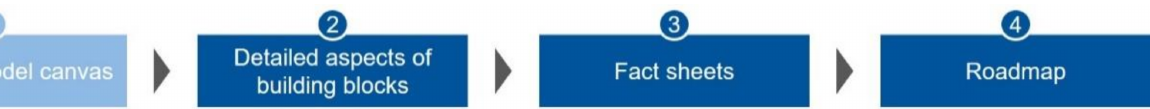
Figure 6. From Business Model Canvas to the